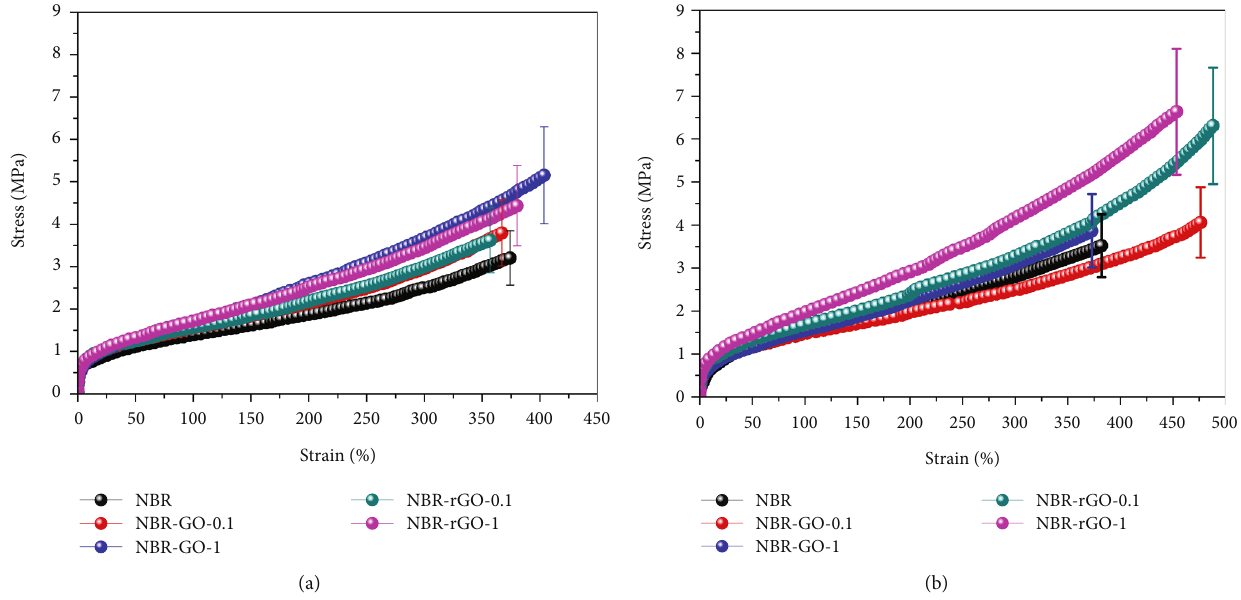
Figure 11: Representatives stress – strain curves for NBR and the fi lled compounds: (a) Compounds prepared without ZnO/SA. (b) Compounds prepared without TMTD